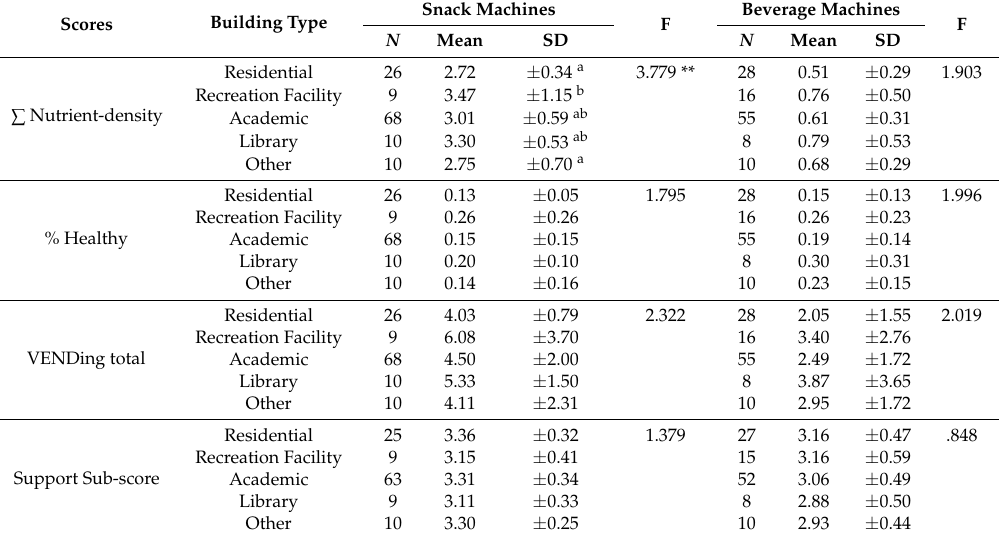
Table 5. Differences between VENDing scores by building type.